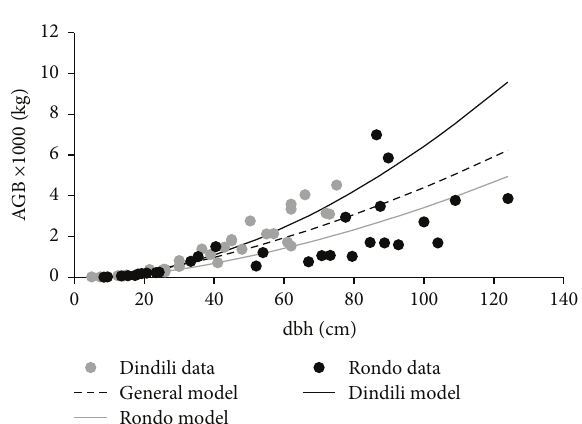
Figure 4: Scatter plot and biomass estimates by applying model (9). Total tree height was predicted using the developed ht-dbh